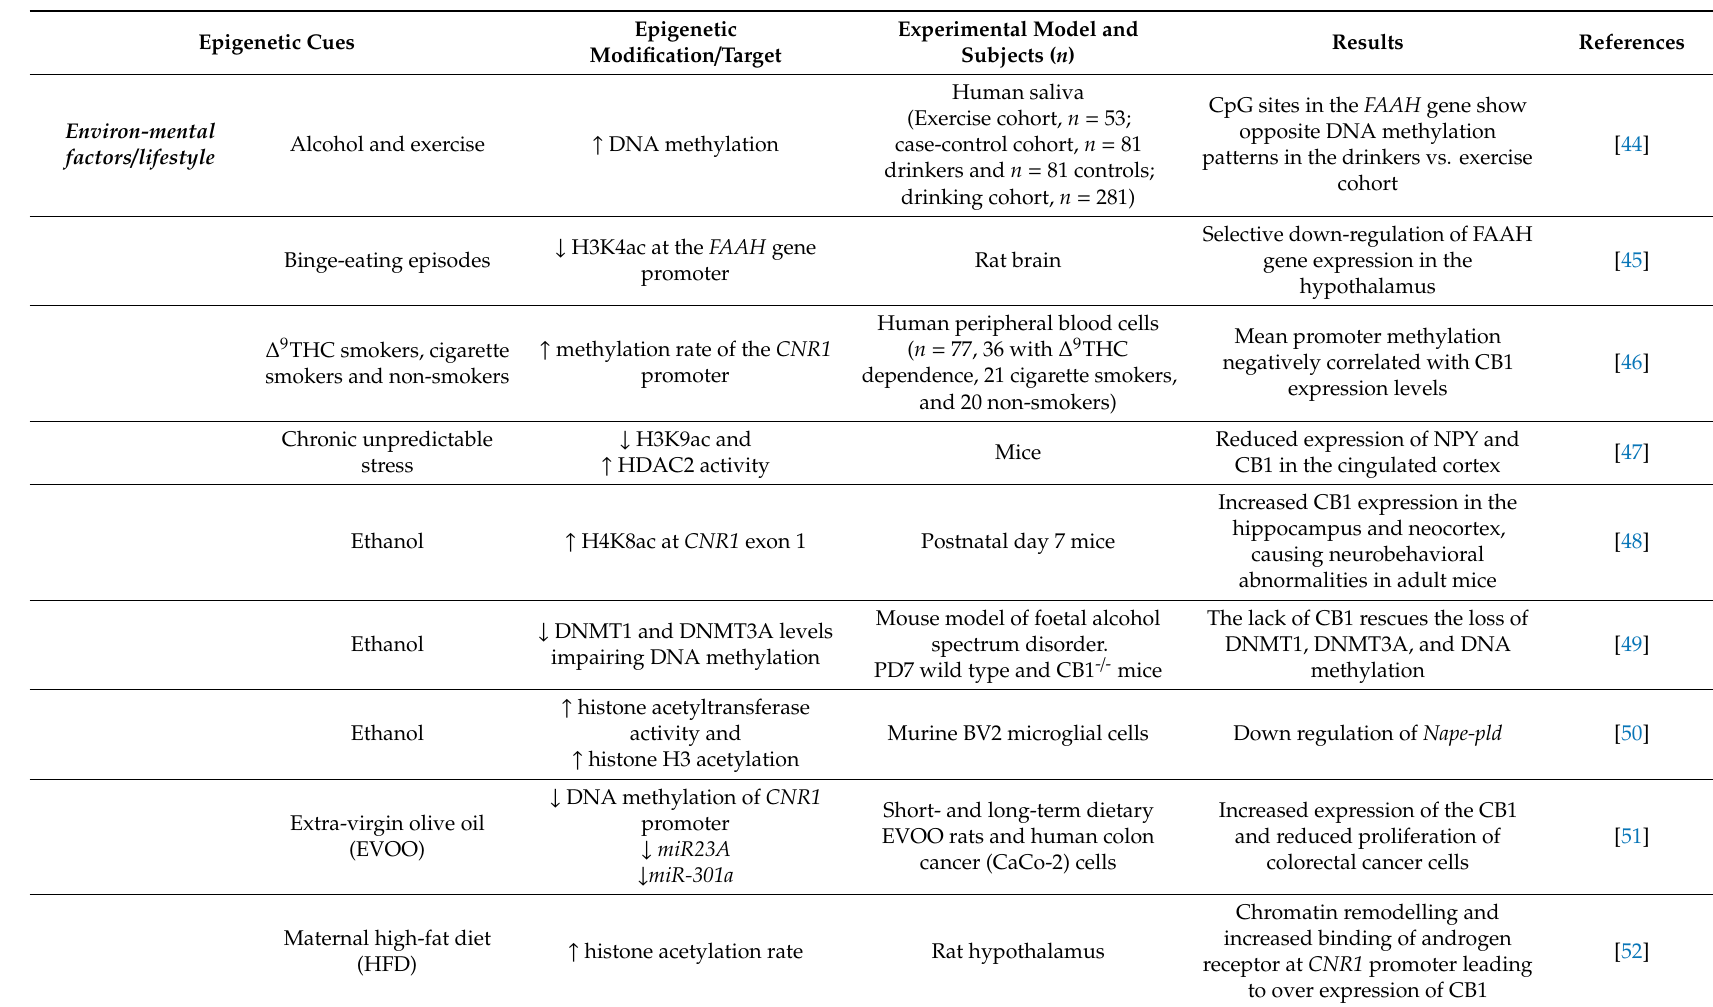
Table 1. The epigenetic modulation of ES by non-canonical ligands and during the disease